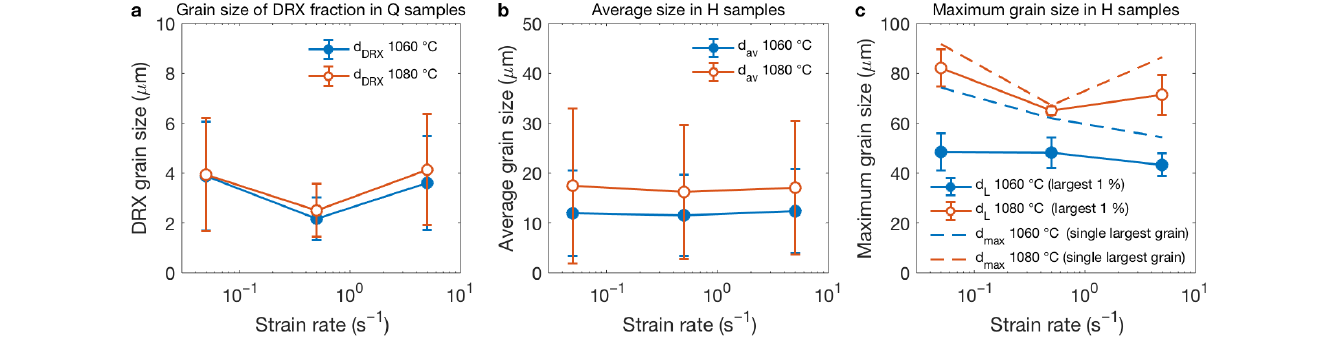
Figure 10. Grain sizes for the investigated deformation parameters. ( a ) the average grain size and standard deviation of the recrystallized grains for the Q samples. ( b ) the average grain size and standard deviation of all grains for the H samples. ( c ) both the grain size of the single largest grain (dashed lines) and the average size and standard deviation of the 1% largest grains (solid lines) for the H